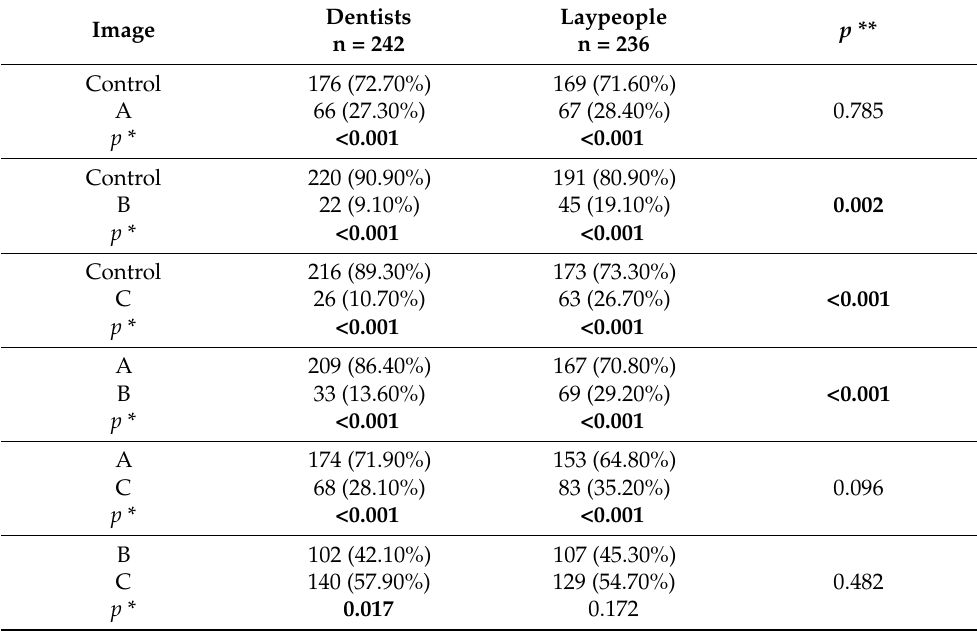
Table 1. Comparison of the perception of attractiveness in each group and between groups. Image